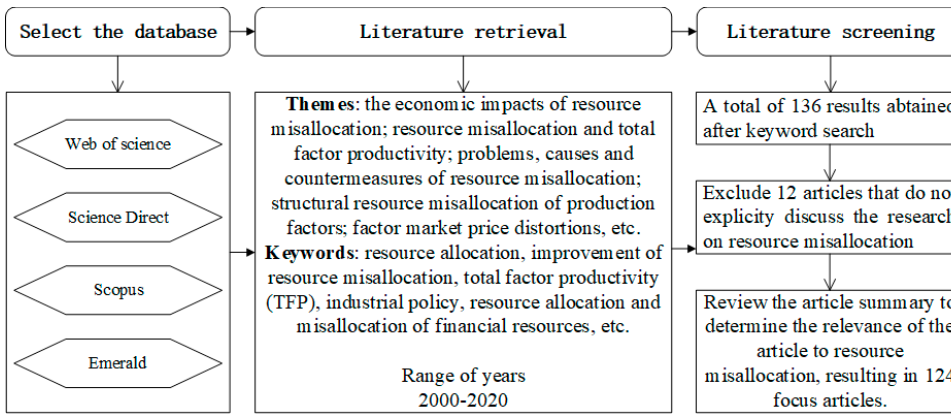
Figure 1. Literature retrieval and screening process .